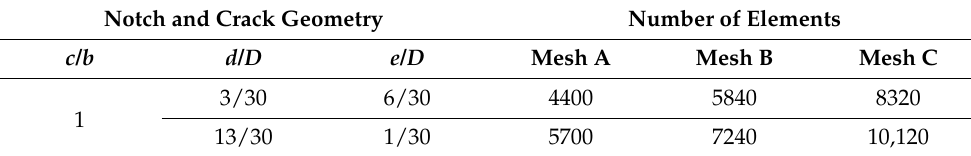
Table 2. Number of mesh elements.